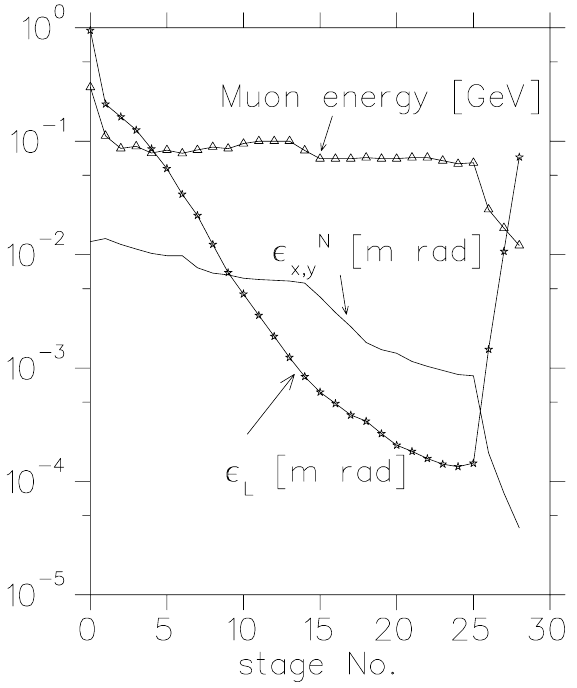
FIG. 23. Transverse ( e x , y ), longitudinal emittance ( e L ), and beam energy vs stage number in the cooling